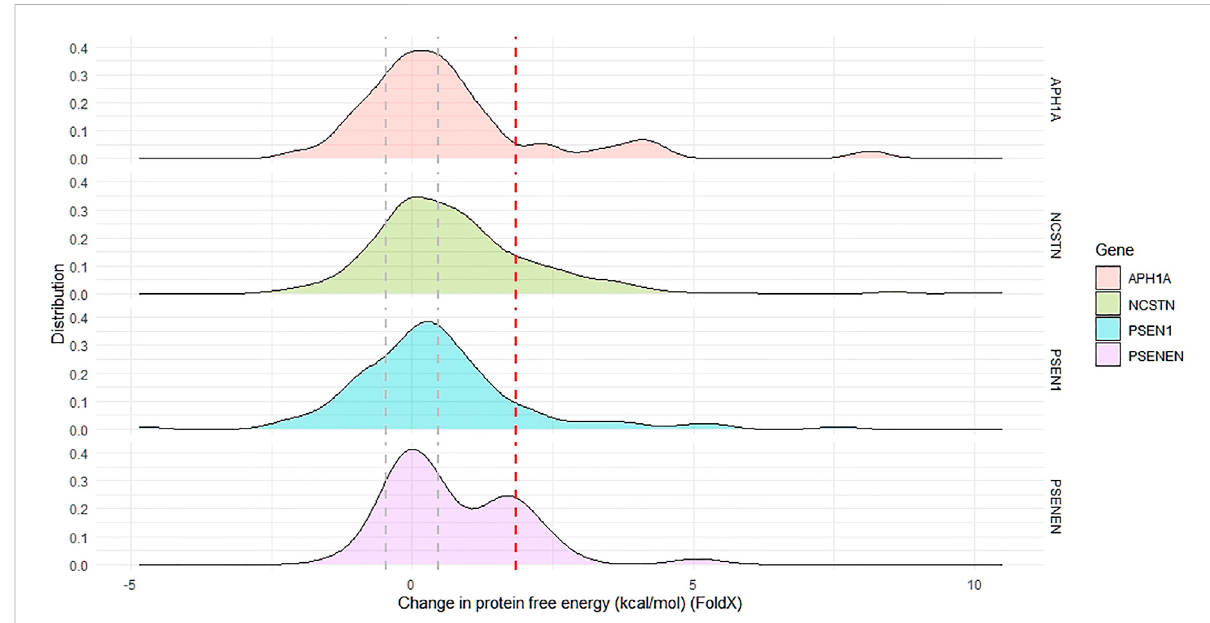
FIGURE 5 The distribution of change in protein free energy in proteins forming the gamma secretase complex. The global distribution of APH1A and PSENENinbimodal.Theareabetweenthegreydottedlinesindicateproportionofreportedmissensevariantswithnet-neutralchangeinfreeenergy, whilst the region beyond the dotted red line indicates the proportion of missense variants having a highly destabilizing change in free